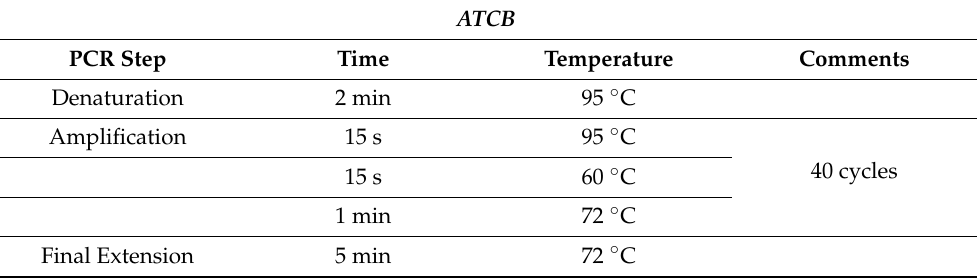
Table 3. Thermocycler conditions for ATCB